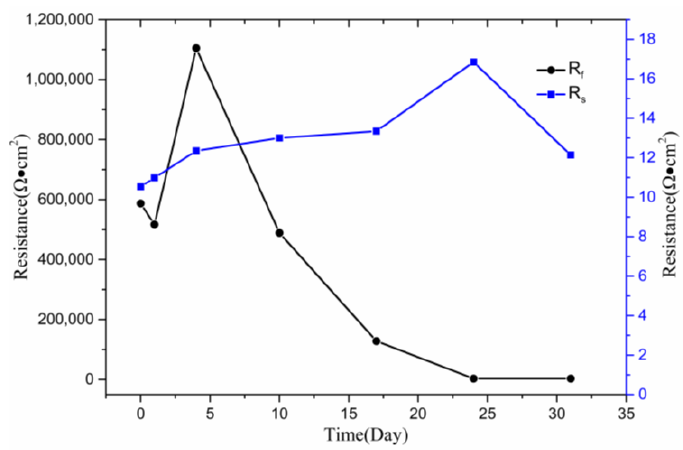
Figure 6. Parameters (resistance) change of equivalent circuits obtained by fitting the experimental results of EIS.